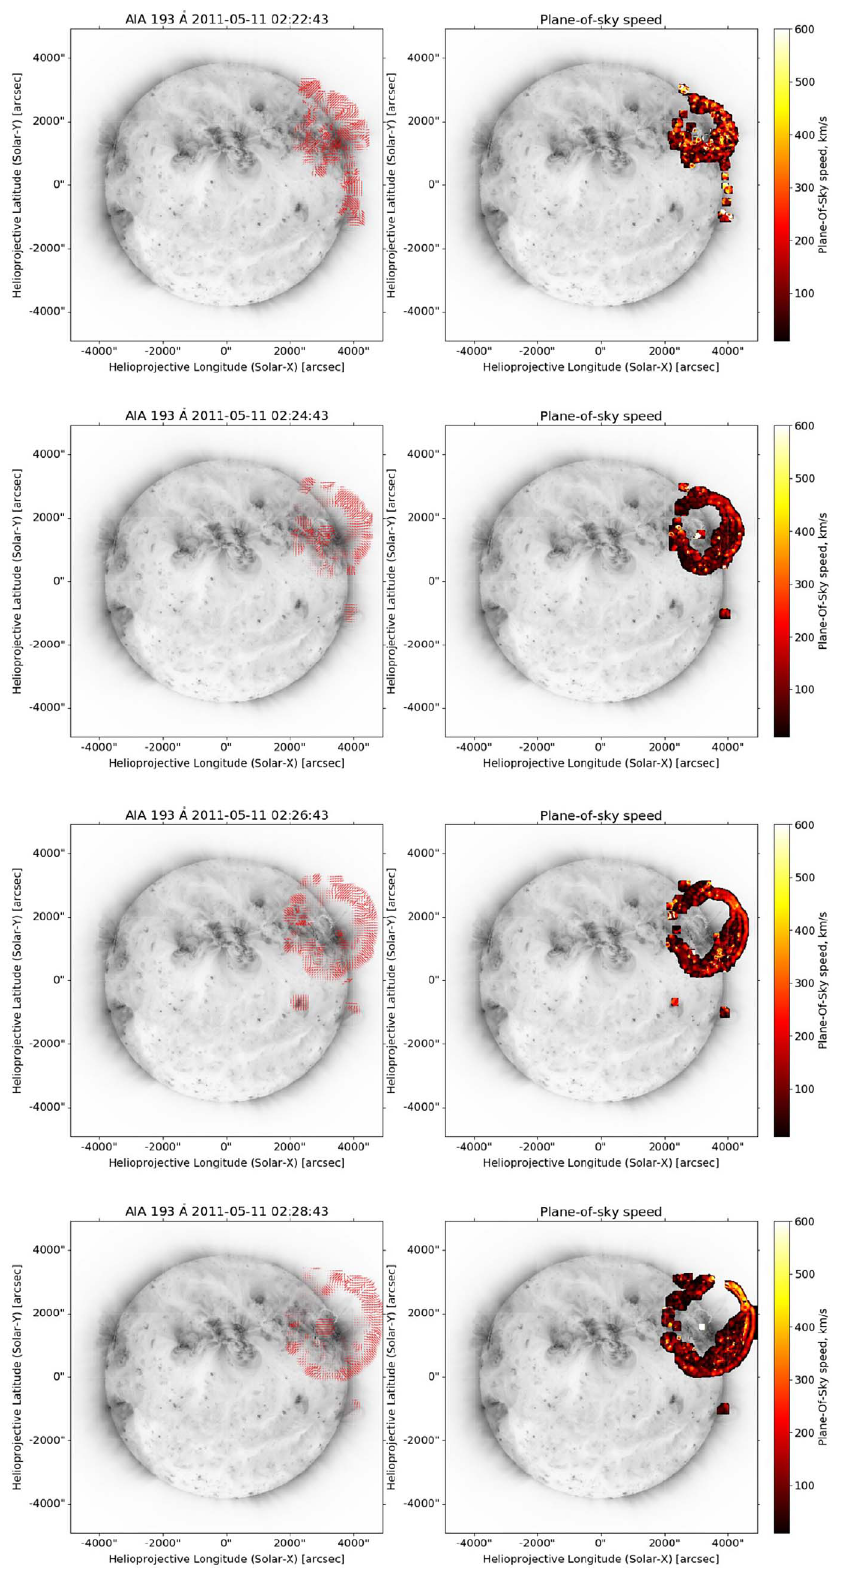
Fig. 8. The output of the FLCT model for the four pairs of consecutive images is shown in Figure 7. Left panels: Arrows showing the plane-of- sky velocity. Right panels: The plane-of-sky